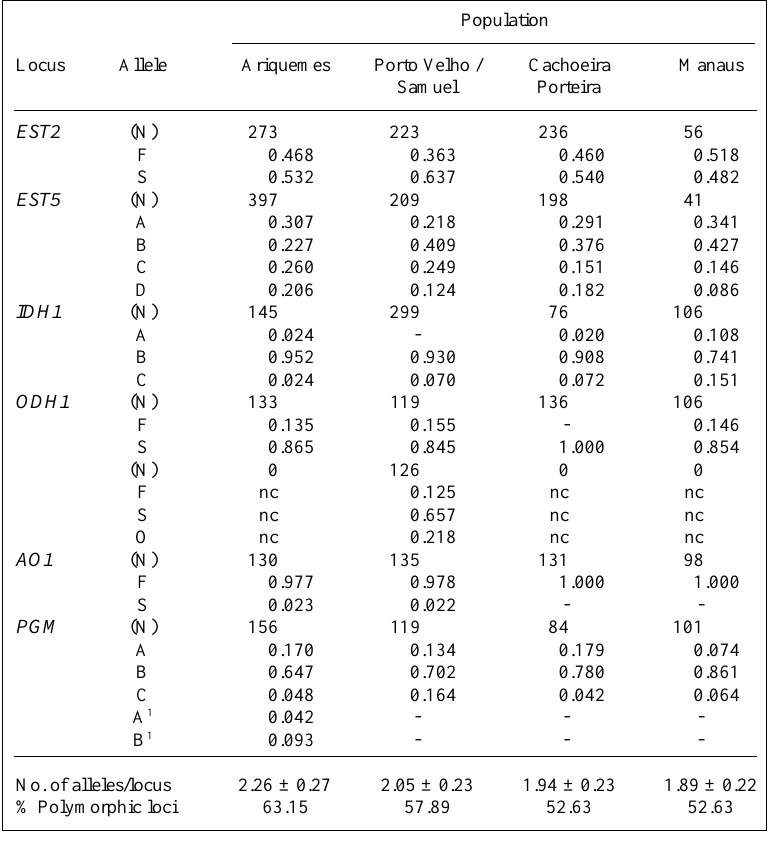
Table I - Gene frequencies of alleles at each locus of the Anopheles darlingi populations analyzed. (N) = Sample size; O = null allele; nc = frequency not calculated; - = inexistent allele; 1 = rare PGM